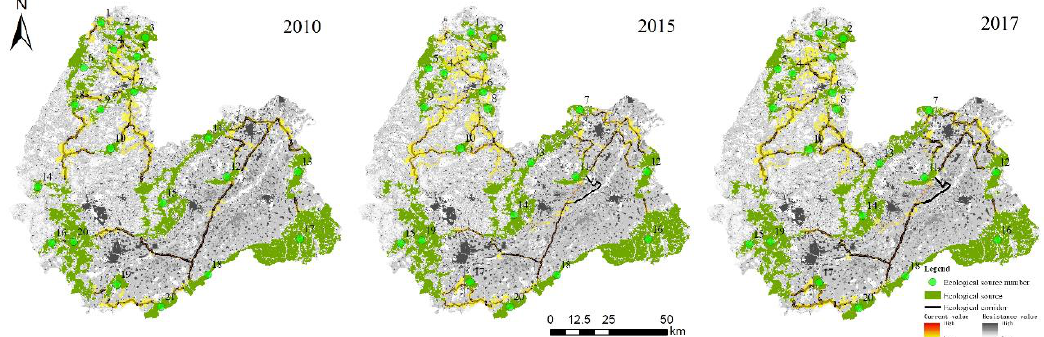
Figure 7. Ecological corridors and current distribution in corridors from 2010 to 2017. The black number is the ecological source number.